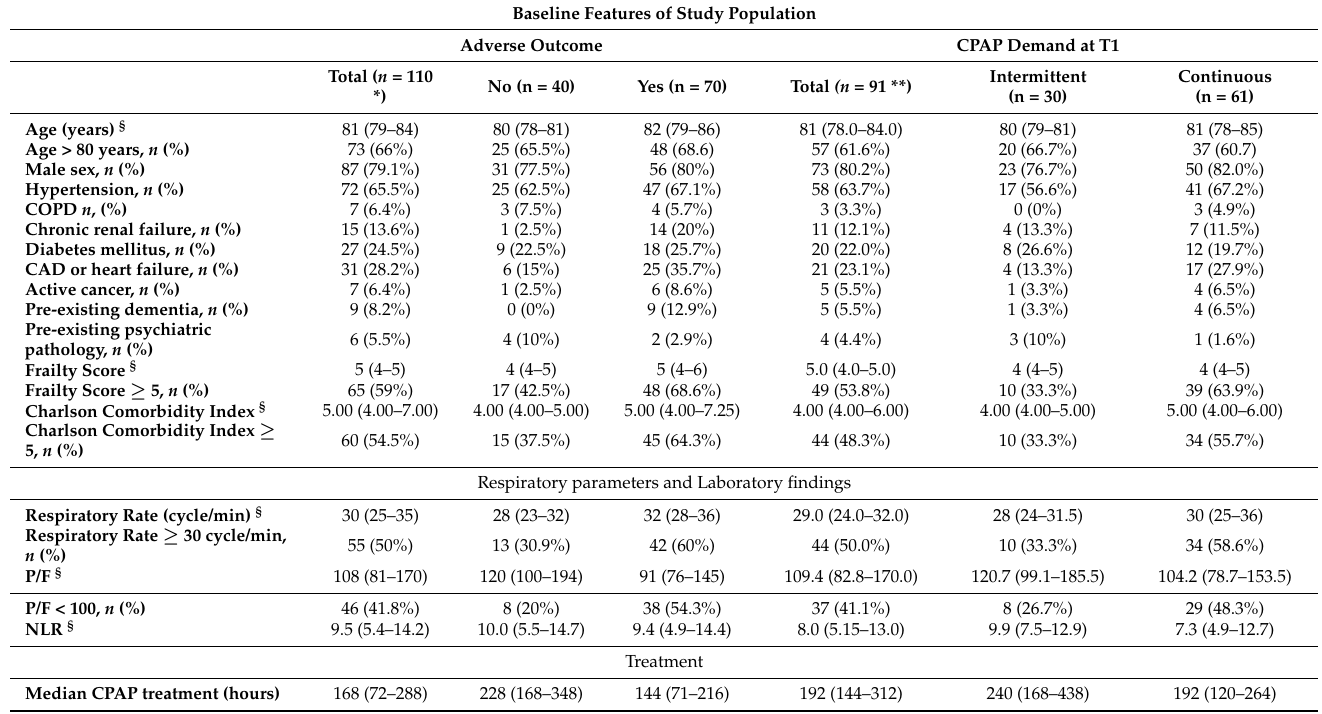
Table 1. Patients’ characteristics, laboratory findings and respiratory parameters at baseline according to the study